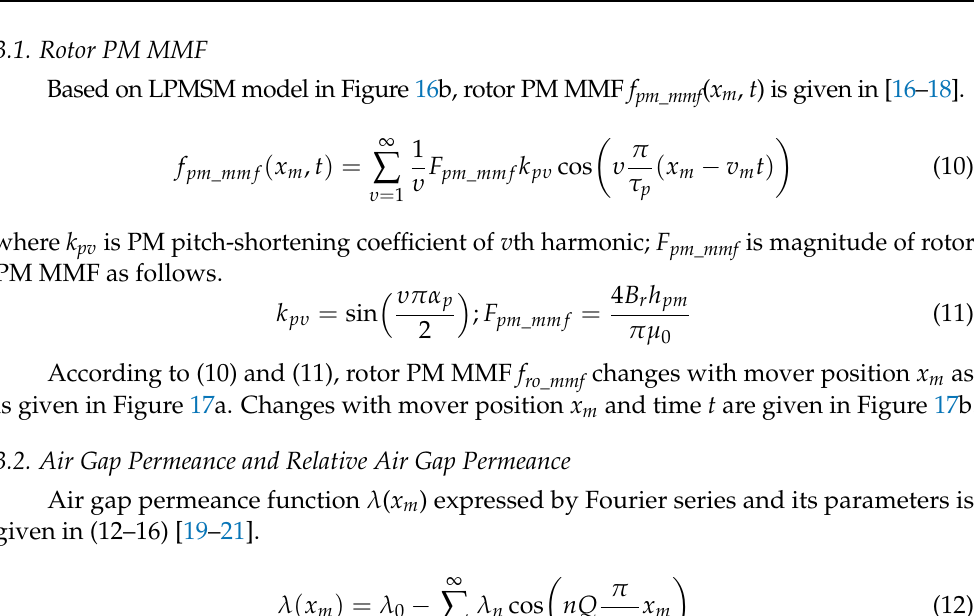
Table 2. Main parameters of axial-flux ISG with DTP-FL winding.